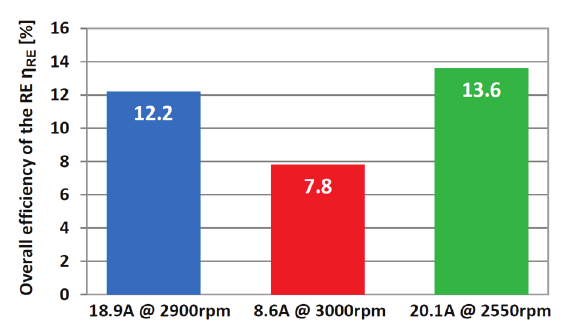
Fig. 7. Comparison of the overall efficiency of the range extender in dif- ferent operating points The maximum efficiency of the range extender in the preliminary experiments was 13.6% and was obtained at the load 20 A and at the engine rotational speed 2550